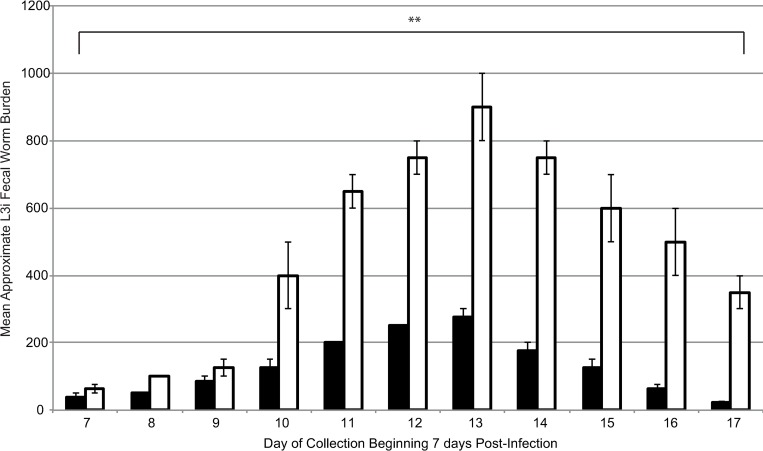
The daf-12(RNAi) larvae that do develop into L3i (black) are able to infect rats when injected subcutaneously but cause significantly less productive infections than control (scrambled siRNA) L3i (white).Approximate worm burden in the feces (as a proxi for the capacity of causing a new infection) was determined by counting the L3i present in fecal cultures after 7 days incubation at 19°C. Fecal cultures were collected daily starting from 7 days post-infection. Error bars represent standard deviation. This experiment was carried out twice. Student’s t-test was performed to determine statistical significance. ** indicates a highly statistically significant difference (p-value <0.001) between the daf-12(RNAi) and control infections (p<0.0001).